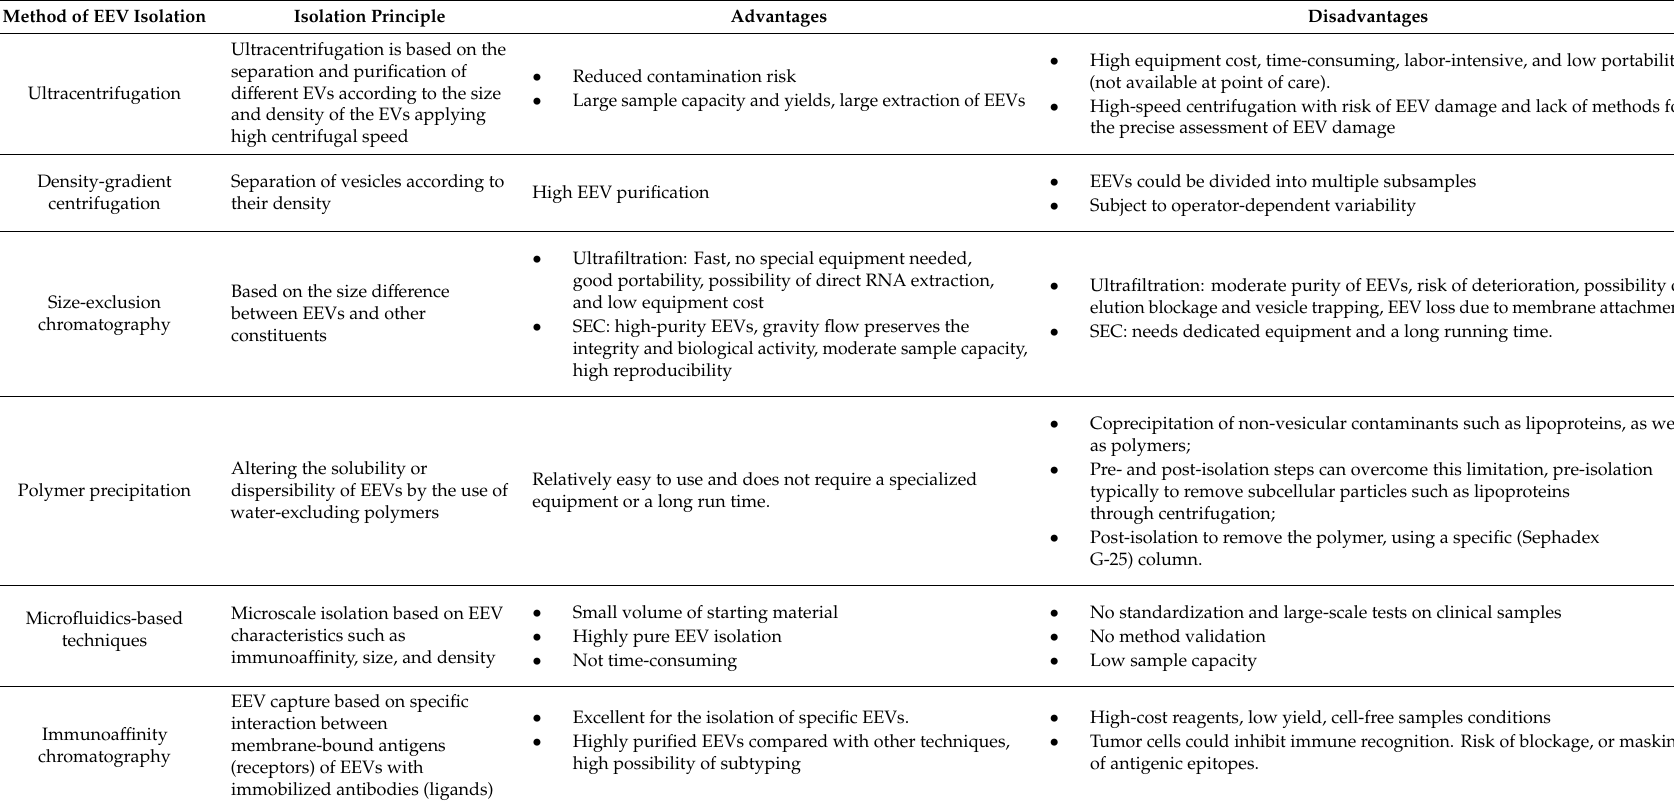
Table 2. EEV isolation